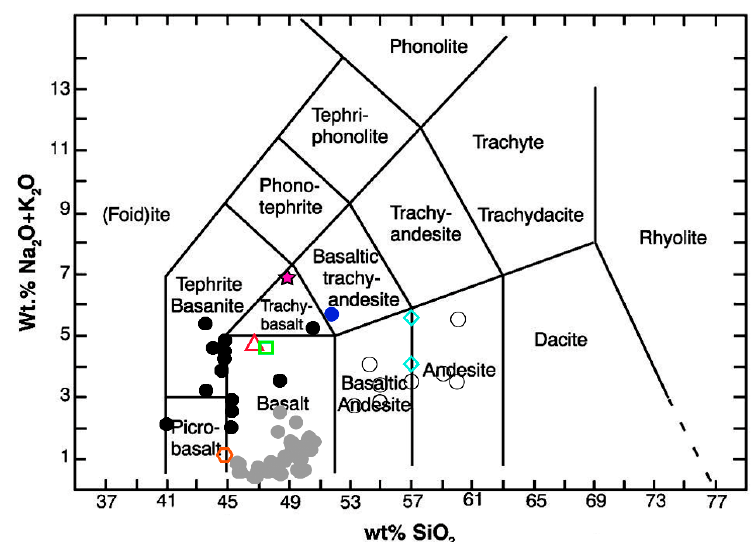
Figure 4. Total Alkalis vs. Silica (TAS) diagram of igneous rock, showing samples from Mars Gale Crater (blue circle and pink star ); Mars meteorites (grey full circles ); Spirit rover (black full circles ); Pathfinder (Blue diamond ); Mars Global Surveyor (black empty circles ); Gusev Crater (red triangle ); picro-basalt meteorite (orange polygon ) in relation to the composition of ash from Etna eruption in 2001 (green square ).